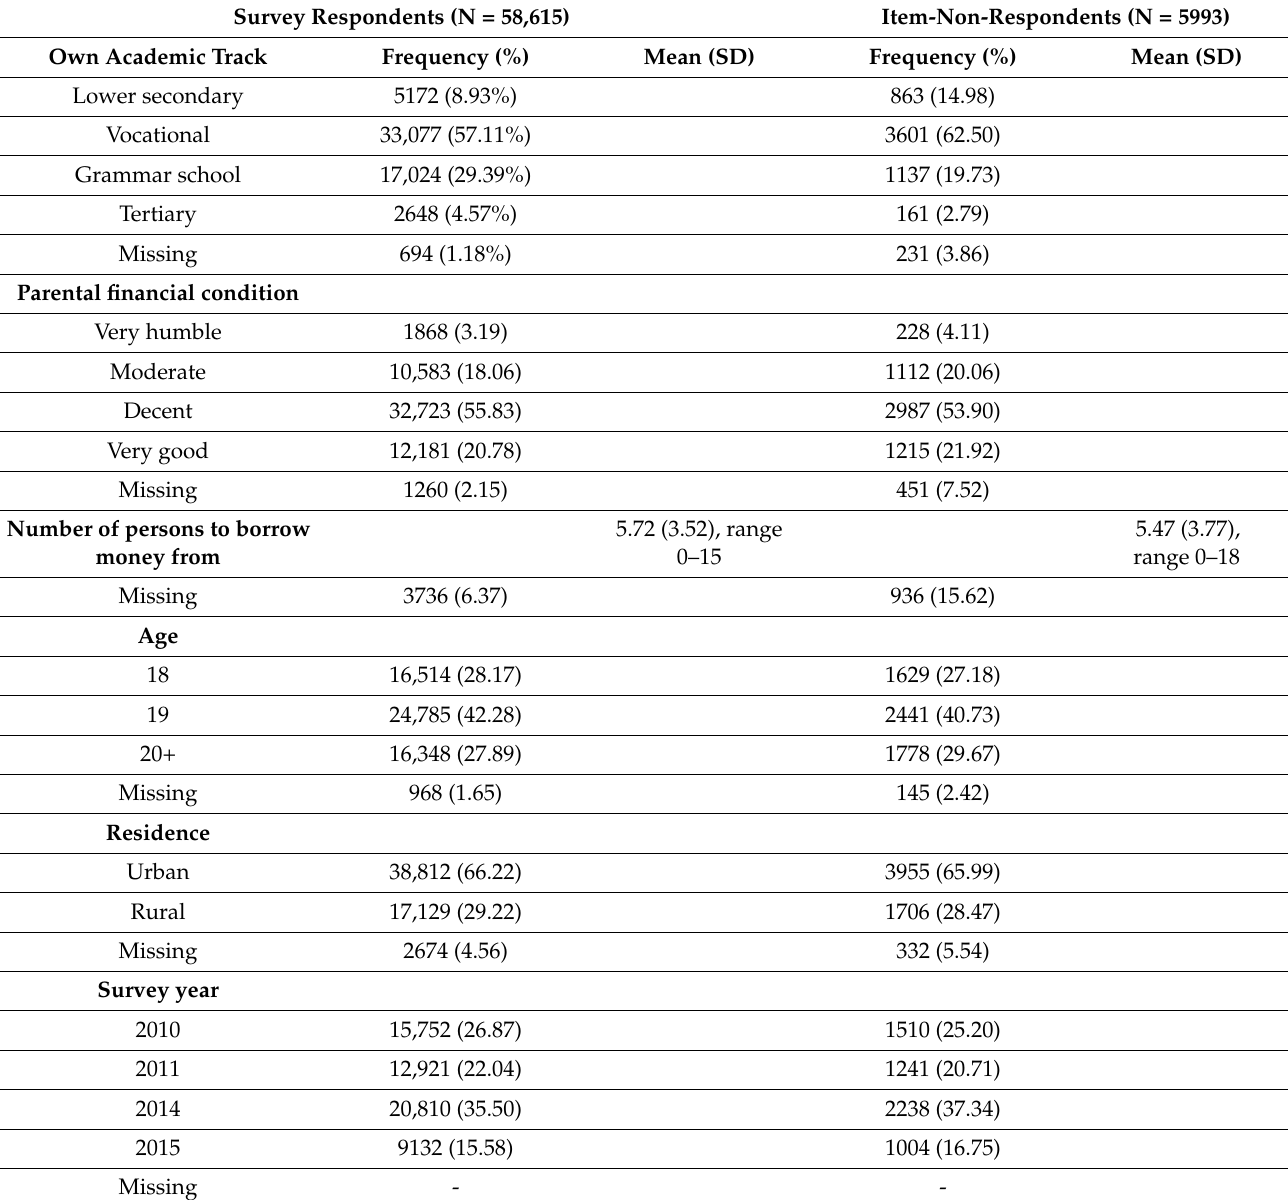
Table 1. Characteristics of capability and functioning item-respondents and